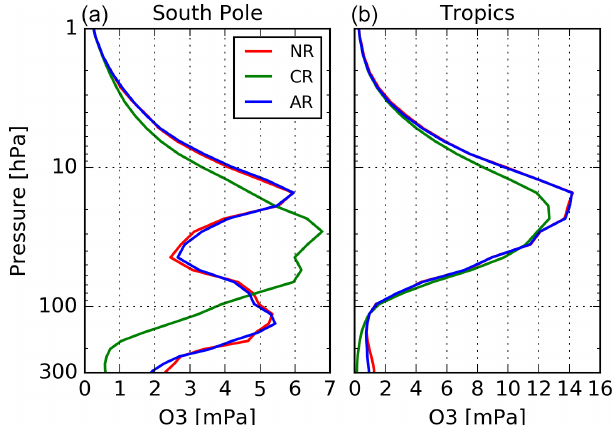
Figure 9. Daily zonal mean ozone profiles (mPa) from NR (red line), CR (green line) and AR (blue line) above the South Pole (poleward of 70 ◦ S, a ) and in the tropics (between 20 ◦ S and 20 ◦ N, b ) on 15 September